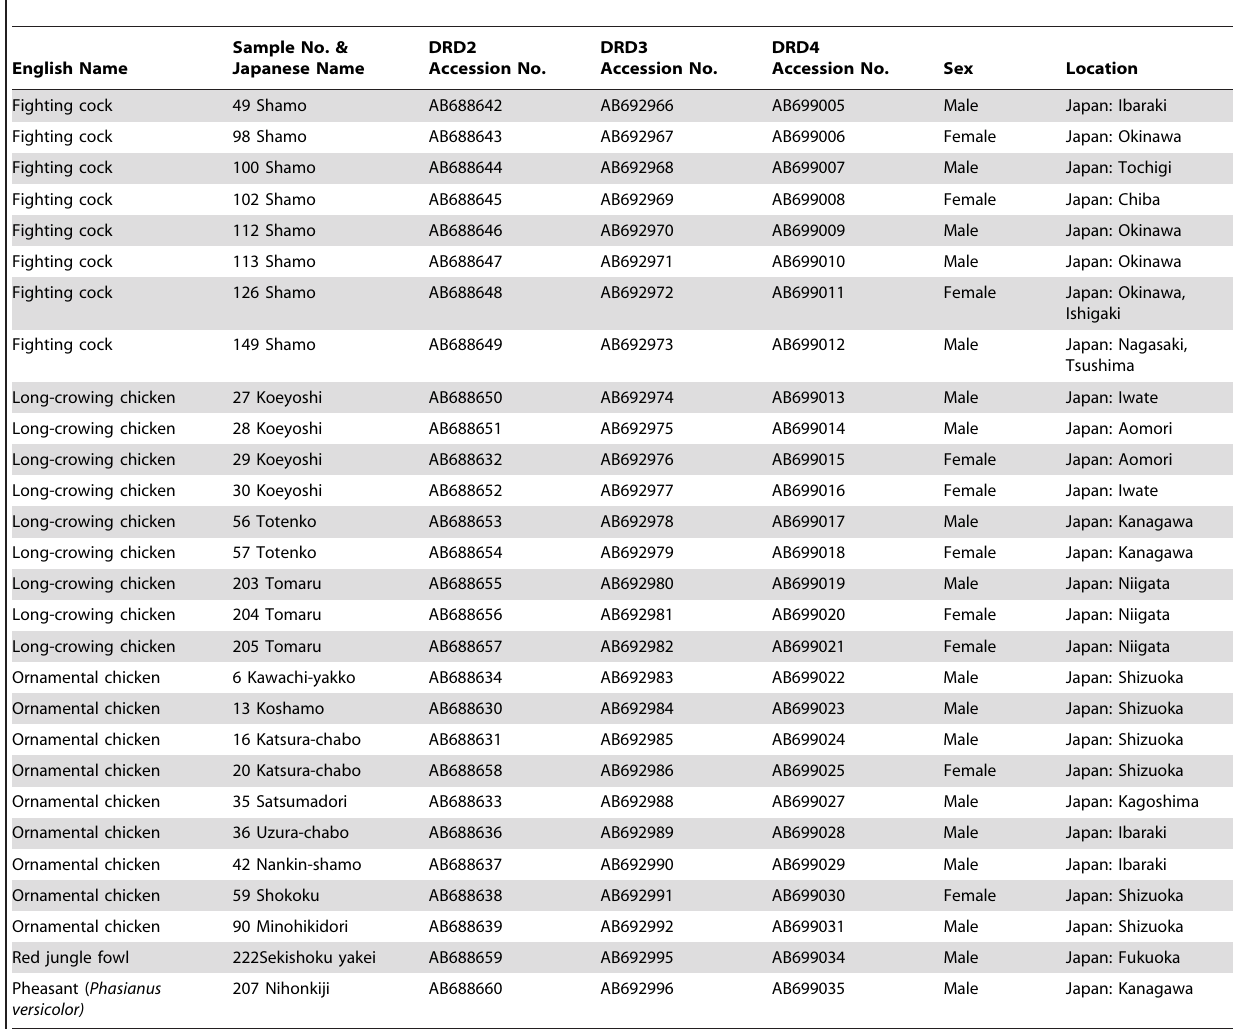
Table 4. List of samples from eight fighting cocks ( Shamo ), nine long-crowing chickens ( Naganakidori ), nine ornamental chickens, one red junglefowl, and one